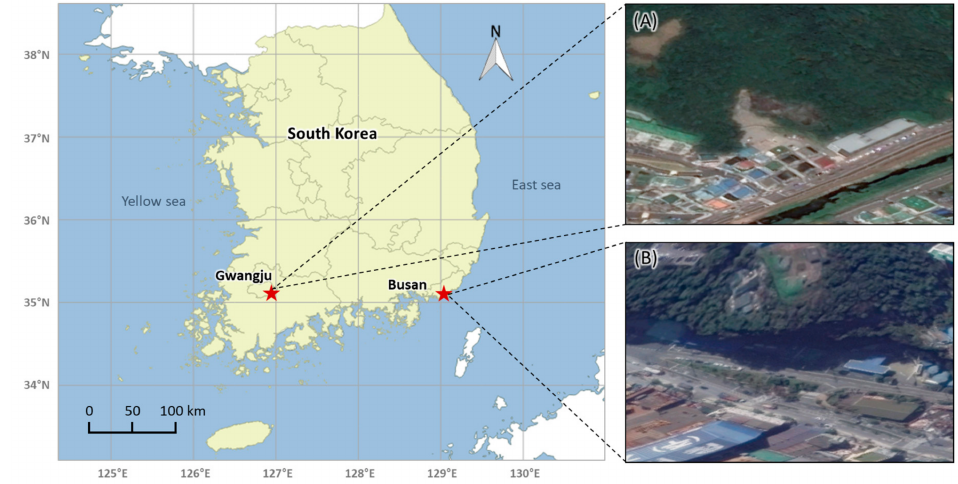
Figure 1. Map showing the study areas: ( A ) located in Gwangju and ( B ) located in